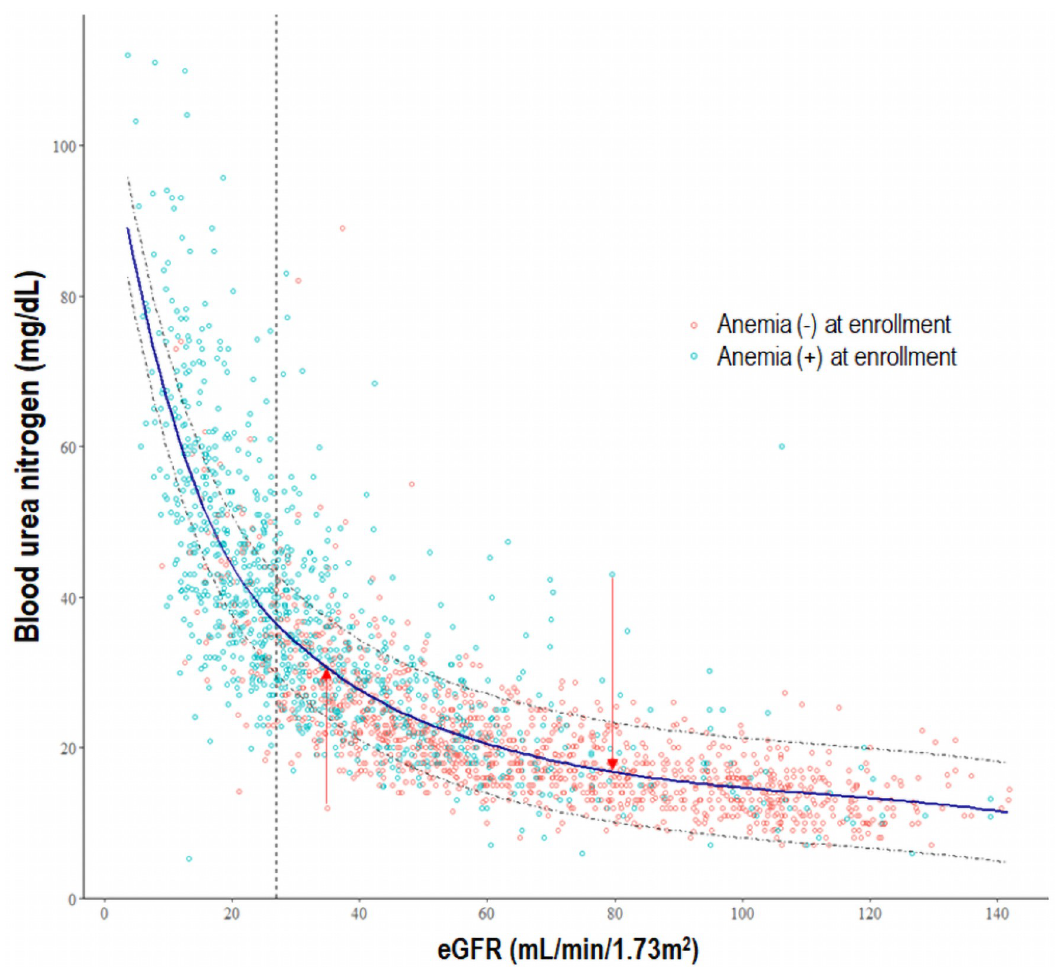
Fig 2. Relationship between eGFR and BUN. The BUN residuals were obtained from the regression curve between baseline BUN and eGFR levels to examine the effect of BUN on anemia development uncorrelated with eGFR. The solid line represents the fitted curve between BUN and eGFR. The BUN residuals were calculated as the vertical distance from each observation point to the fitted curve (arrows). Even at the same eGFR level, BUN concentration demonstrated a wide range (exemplified by a vertical dotted line). The dotted curve represents ± 0.5 × standard deviation from the fitted curve. The blue circles represent patients who had anemia at enrollment and the red circles denote patients who did not have anemia at enrollment. BUN, blood urea nitrogen; eGFR, estimated glomerular filtration rate as determined by the CKD-EPI creatinine